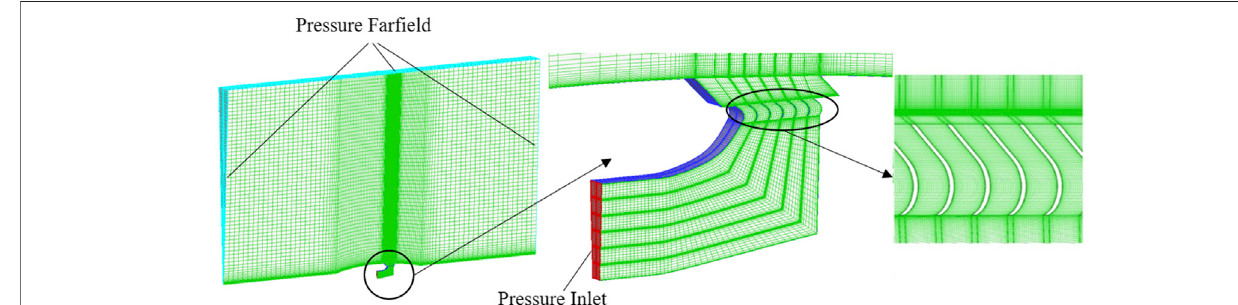
FIGURE 9 | Grid diagram of cascade calculation area.